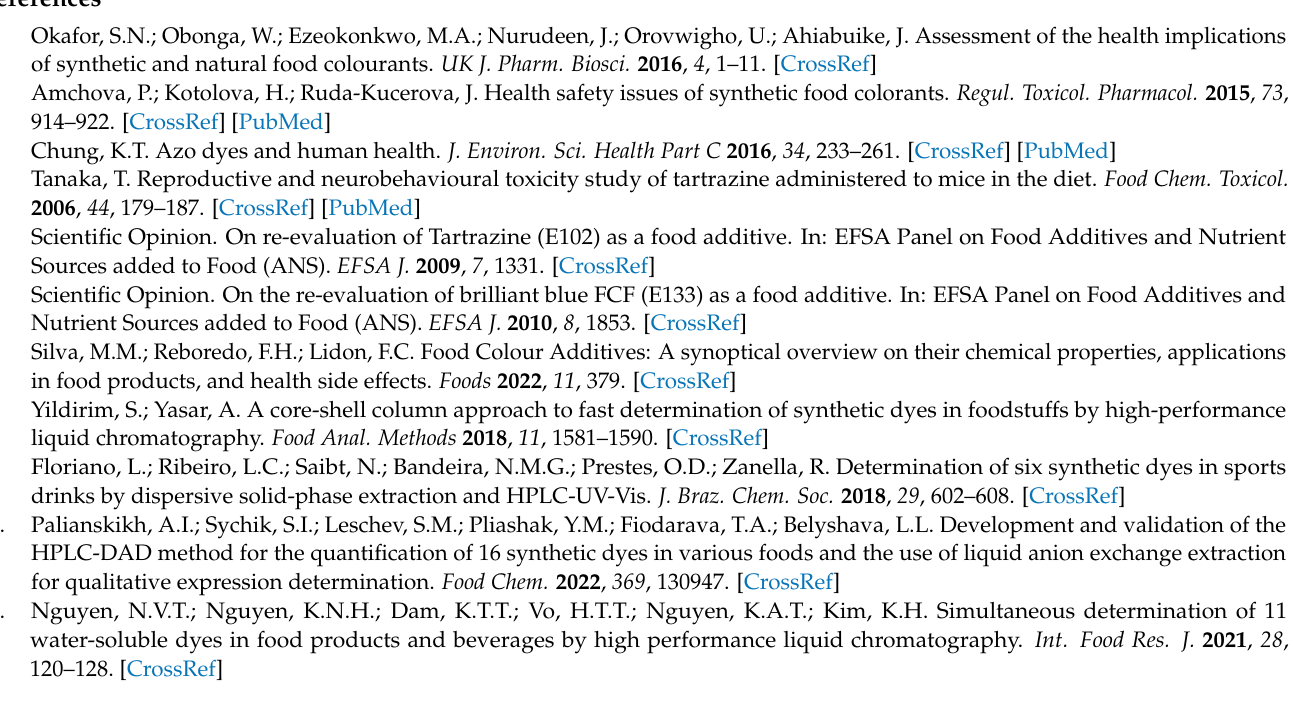
buffer pH 7.0: (a) the changes of peak potential separation; (b) changes in the oxidation currents of tartrazine; (c) changes in the oxidation currents of brilliant blue FCF, Figure S4: Calibration plots of dyes on the MnO 2 nanorods-modified GCE in phosphate buffer pH 7.0: (a) Tartrazine; (b) brilliant blue FCF, Figure S5: Baseline-corrected differential pulse voltammograms for the non-equimolar mixtures of tartrazine and brilliant blue FCF on the MnO 2 nanorods-based sensor in phosphate buffer pH 7.0: (a) various concentrations of brilliant blue FCF at the fixed 2.5 µ M concentration of tartrazine; (b) various concentrations of tartrazine at the fixed 2.5 µ M concentration of brilliant blue FCF. Pulse amplitude = 75 mV, pulse time = 25 ms, υ = 20 mV s − 1 , Figure S6: Baseline-corrected differential pulse voltammograms of 300 µ L of real samples on the MnO 2 nanorods-based sensor in phosphate buffer pH 7.0: (a) sample 1 with the standard additions of brilliant blue FCF; (b) sample 2 with the standard additions of tartrazine. Pulse amplitude = 75 mV, pulse time = 25 ms, υ = 20 mV s − 1 , Table S1: Recovery of tartrazine and brilliant blue FCF in real samples using MnO 2 nanorods-based sensor in phosphate buffer pH 7.0 ( n = 5; p =